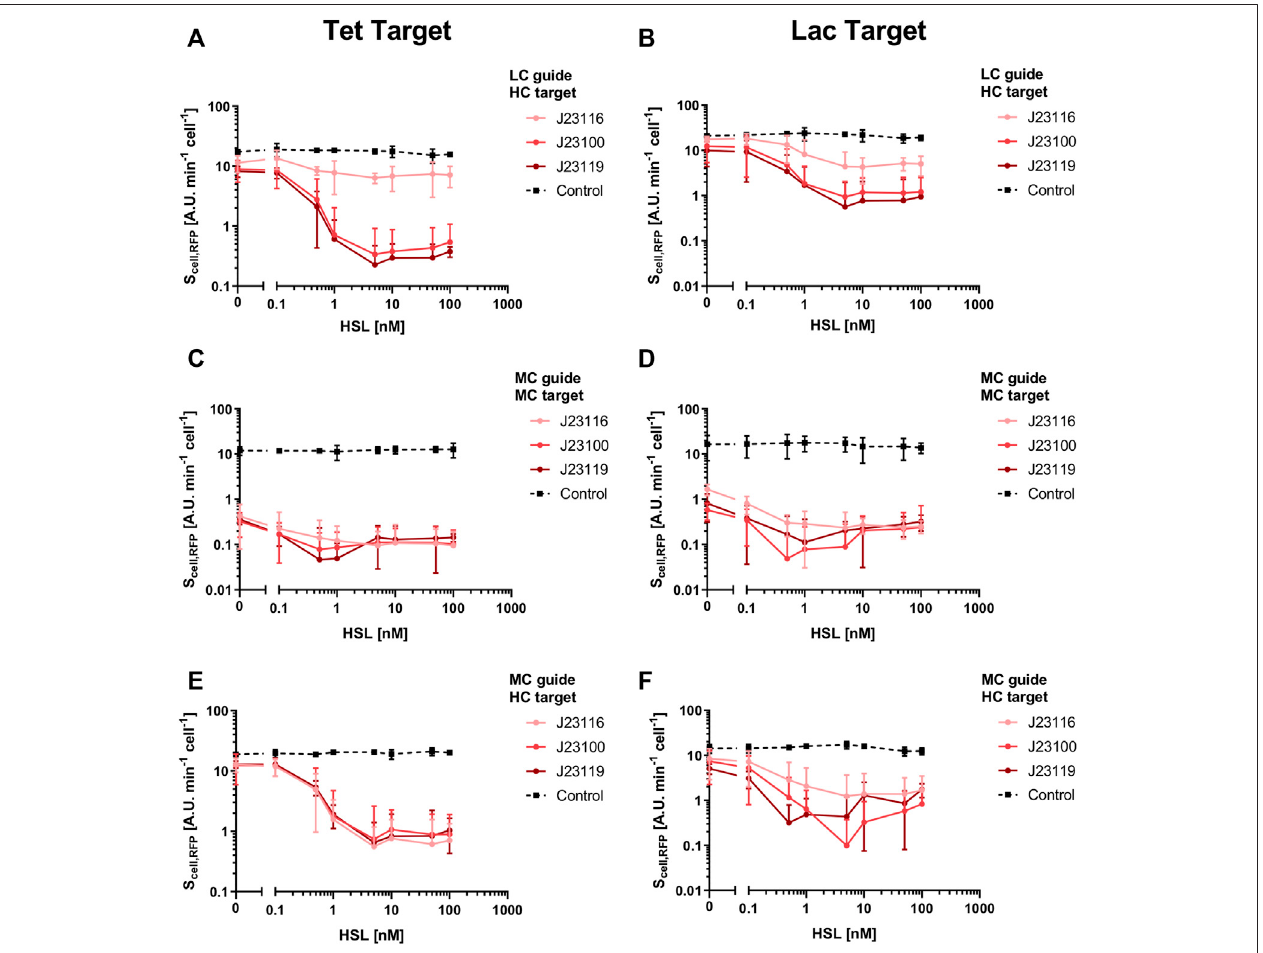
FIGURE 4 | Transfer functions of recombinant strains with HSL-inducible dCas9 and constitutive sgRNA. Transfer curves, with RFP as output, are reported as a functionofHSL. Dataare shown astheaverageRFP synthesis rateper cell. In each panel, the copy number ofthesgRNAconstitutive cassette(low copy — LC, medium copy — MC) and the copy number of the target (medium copy — MC, high copy — HC) are reported. Two different targeting systems [Tet — panels (A,C,E) , and Lac — panels (B,D,F) ]arereported:gPtetandgPlac,whichrepresstheP LtetO1 andP LlacO1 promoters,respectively,thatdriveRFP.Eachpanelincludesfourcurves: three of them correspond to circuits with the sgRNA under the control of three different constitutive promoters of diverse strengths (weak, medium and strong for J23116,J23100andJ23119,respectively),andonecurvecorrespondstoanon-speci fi ctargetingcontrolinwhichthemedium-strengthJ23100promoterconstitutively transcribes a non-targeting sgRNA: gPlac and gPtet for the P LtetO1 and P LlacO1 promoters in the Tet and Lac systems, respectively. Data points represent the average value and error bars represent the standard errors of the mean of at least three independent